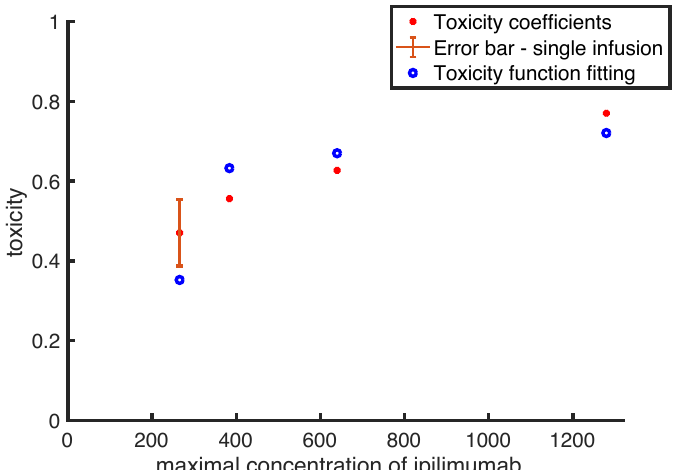
Figure 2. Comparison between toxicity coefficients (red filled points) and the outputs of the toxicity function (blue empty points) evaluated reproducing the same clinical protocols described in Table 3. The point related to the single infusion is represented with the relative error-bar.